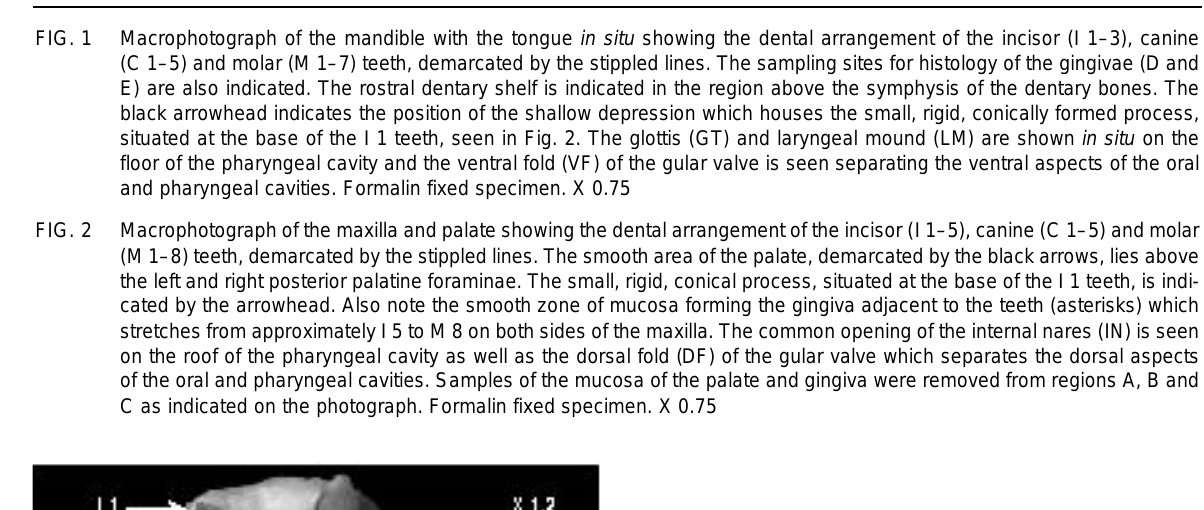
FIG. 3 Macrophotograph of the rostral portion of the mandible (I 1 to C 5). The gingiva is seen to have a slightly cob- bled appearance towards the rostral tip above the dentary symphysis. The black arrow indicates a shal- low depression which houses the small, rigid, conical- ly-shaped maxillary process seen in Fig. 2. The blocked arrow shows a hole made by the hook in the abattoir when the carcass was suspended during the eviscer- ation process. I 1 = Incisor 1; C 1, C 5 = Canine 1